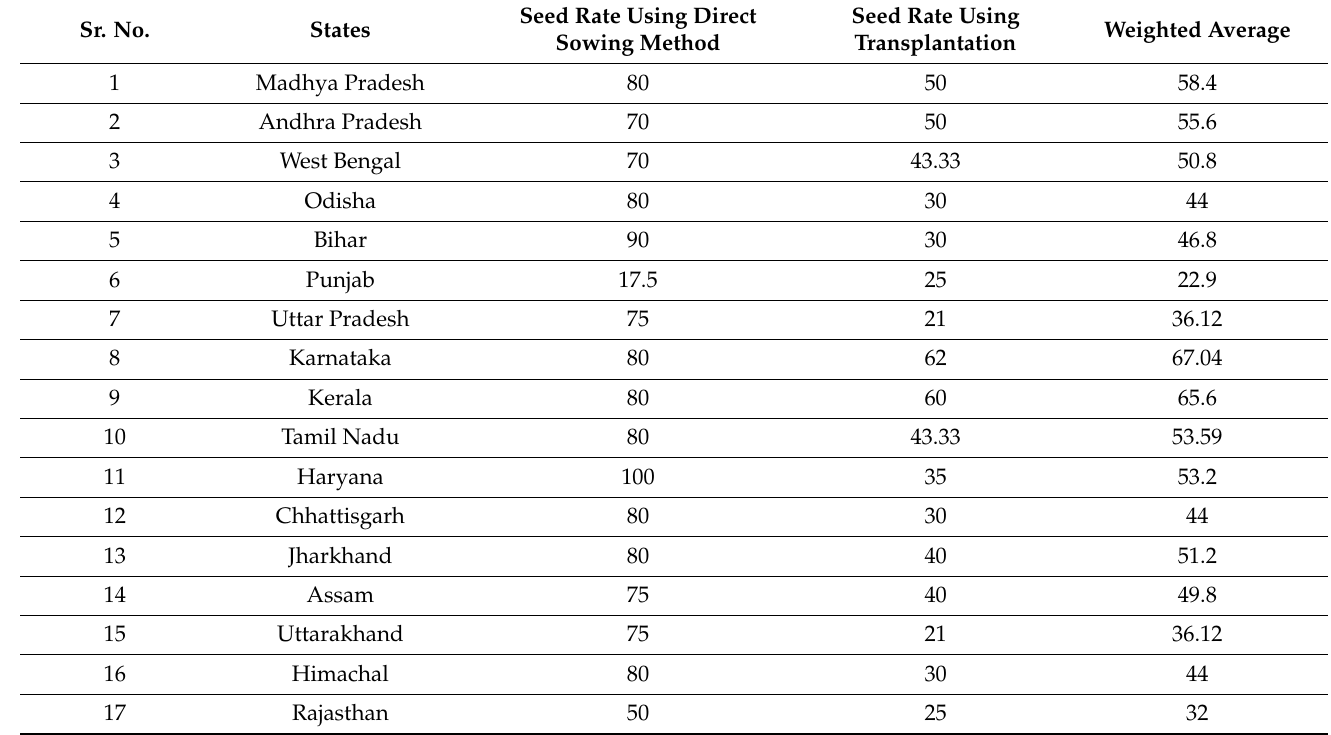
Table 1. Seed rates for different rice establishment